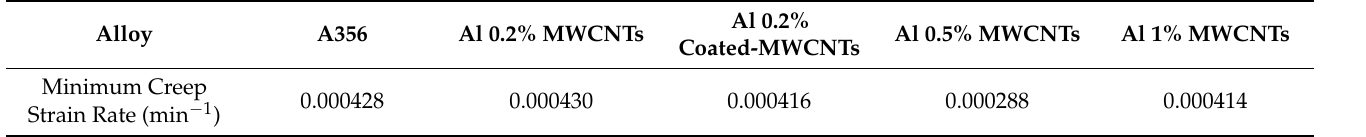
Table 6. Minimum creep strain rate of A356 aluminum alloy and nanocomposites made with 0.2%, 0.2%-coated, 0.5%, and 1% MWCNTs.